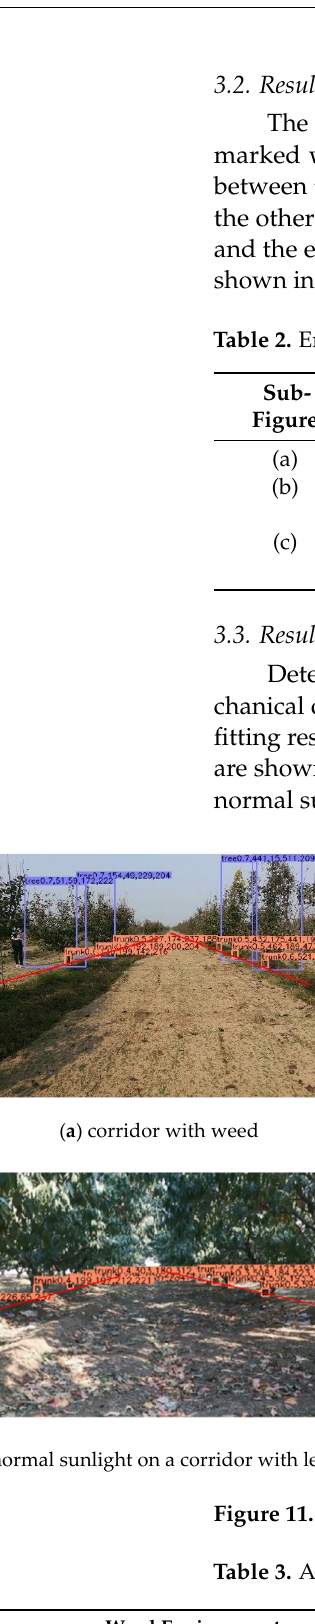
Table 1. Detection accuracy.